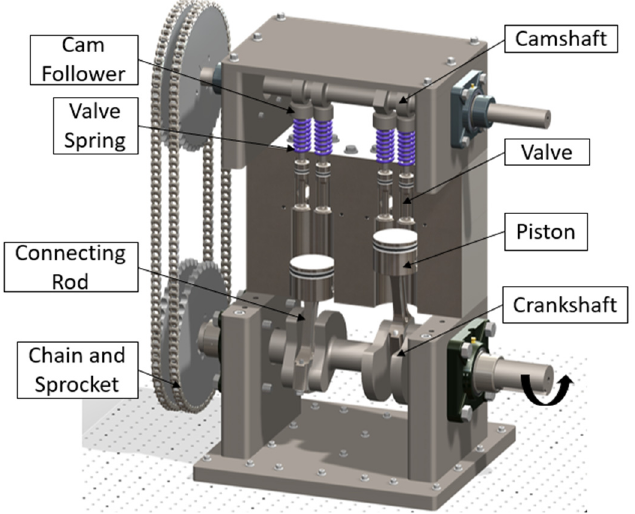
Figure 6. Main components of the twin-cylinder sCO 2 piston engine.